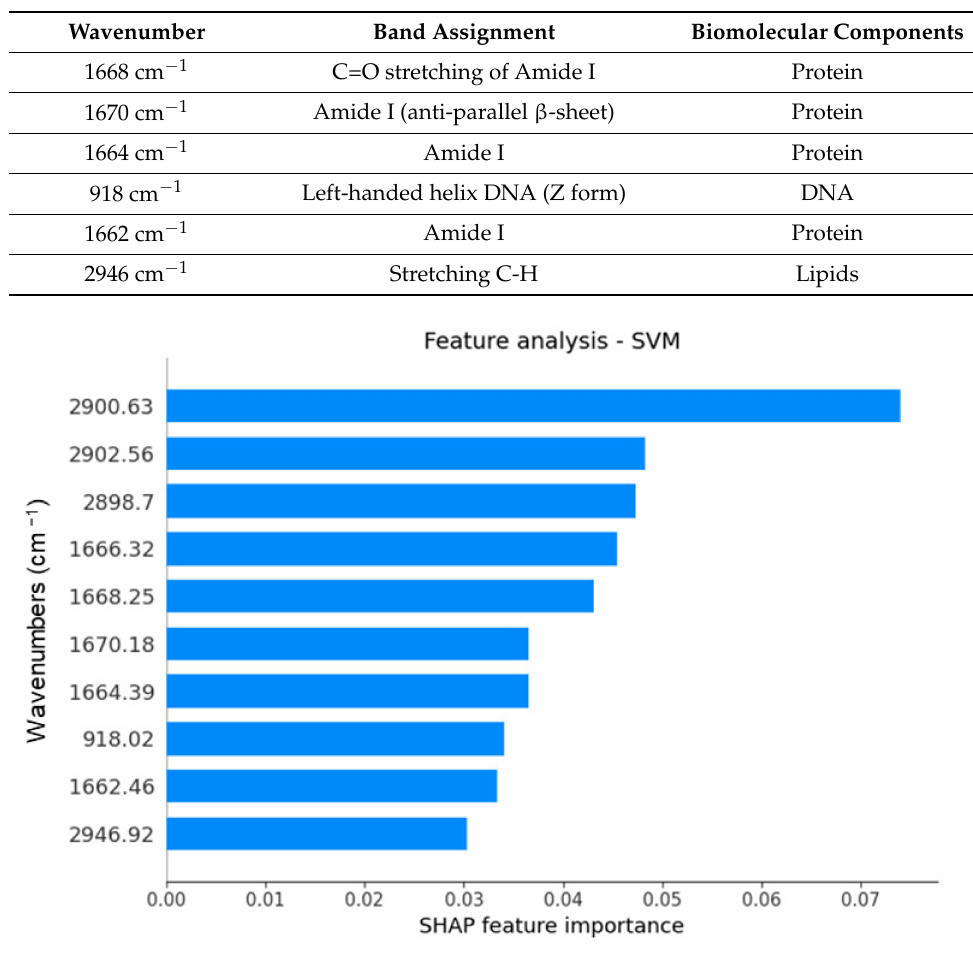
Figure 3. The feature importance (SHAP value) graph of SVM